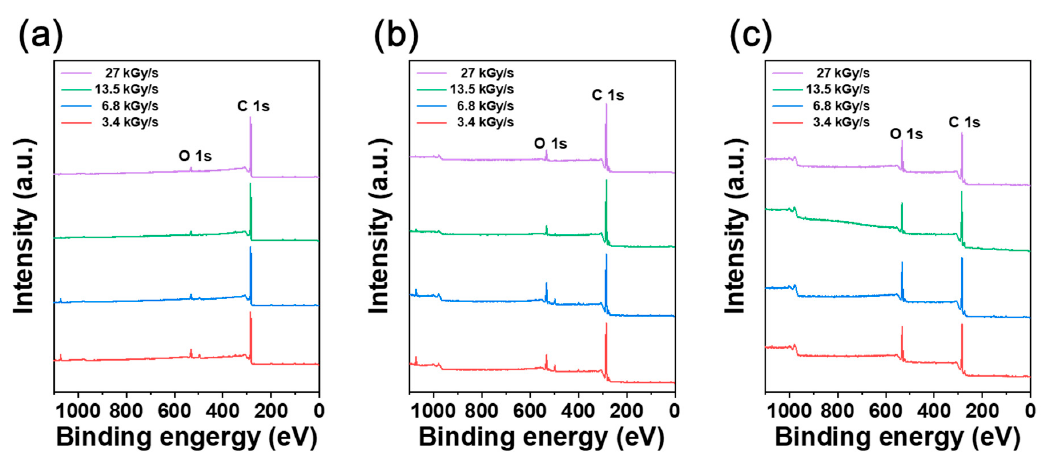
Figure 3. XPS survey scan spectra of ( a ) CFRTP, ( b ) HDPE, and ( c ) CF irradiated at various absorbed dose rates. Table 2. Atomic percentage and C / O ratio of CFRTP, HDPE, and CF irradiated at various absorbed dose rates. Absorbed Dose Rate at% (kGy / s) C1s O1s Na1s N1s Si2p C / O Ratio